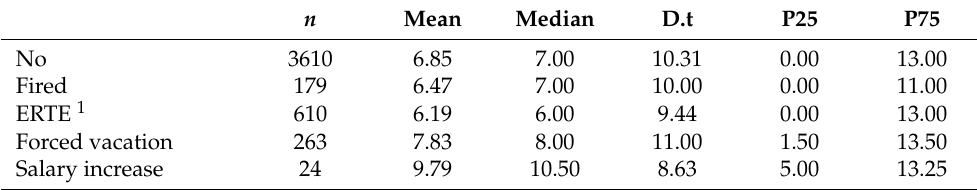
Table 5. Difference between state and trait anxiety and “Have you undergone a contractual